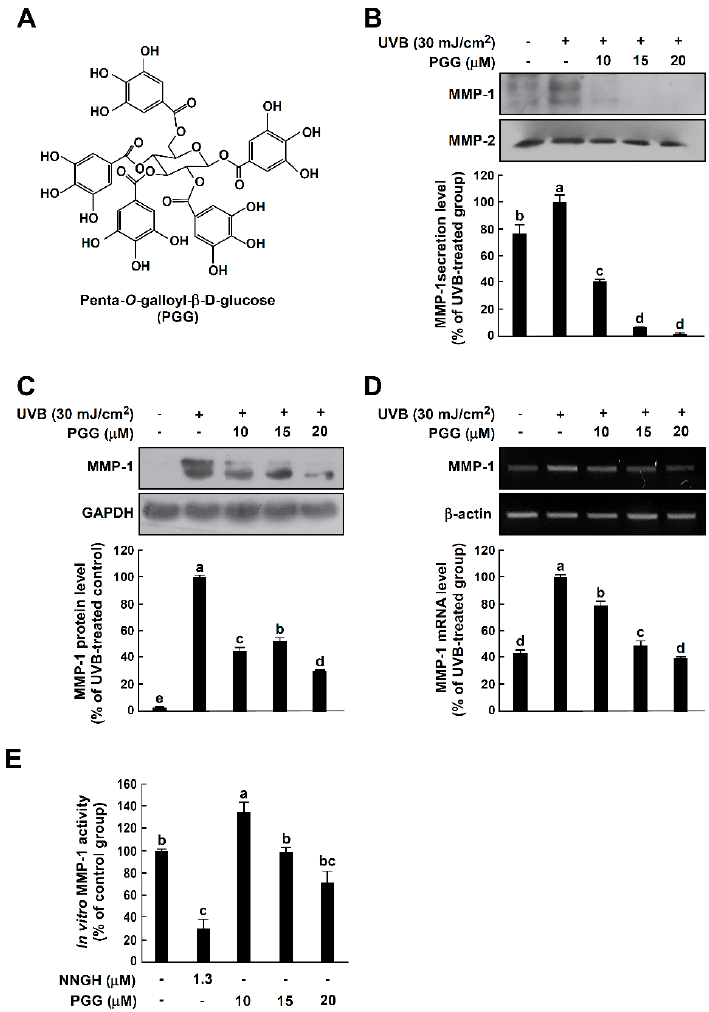
Figure 1. Effect of PGG on UVB-induced MMP-1 expression in HaCaT cells. ( A ) Chemical structure of PGG. ( B ) Effect of PGG on UVB-induced MMP-1 secretion in cell culture media. PGG (10, 15 and 20 μ M) was treated for 1 h before UVB exposure (30 mJ/cm 2 ) to cells. After 48 h, conditioned culture media were collected. Western blot analysis using specific antibodies against MMP-1 protein was performed to determine levels of MMP-1 secretion. ( C ) Effect of PGG on UVB-induced MMP-1